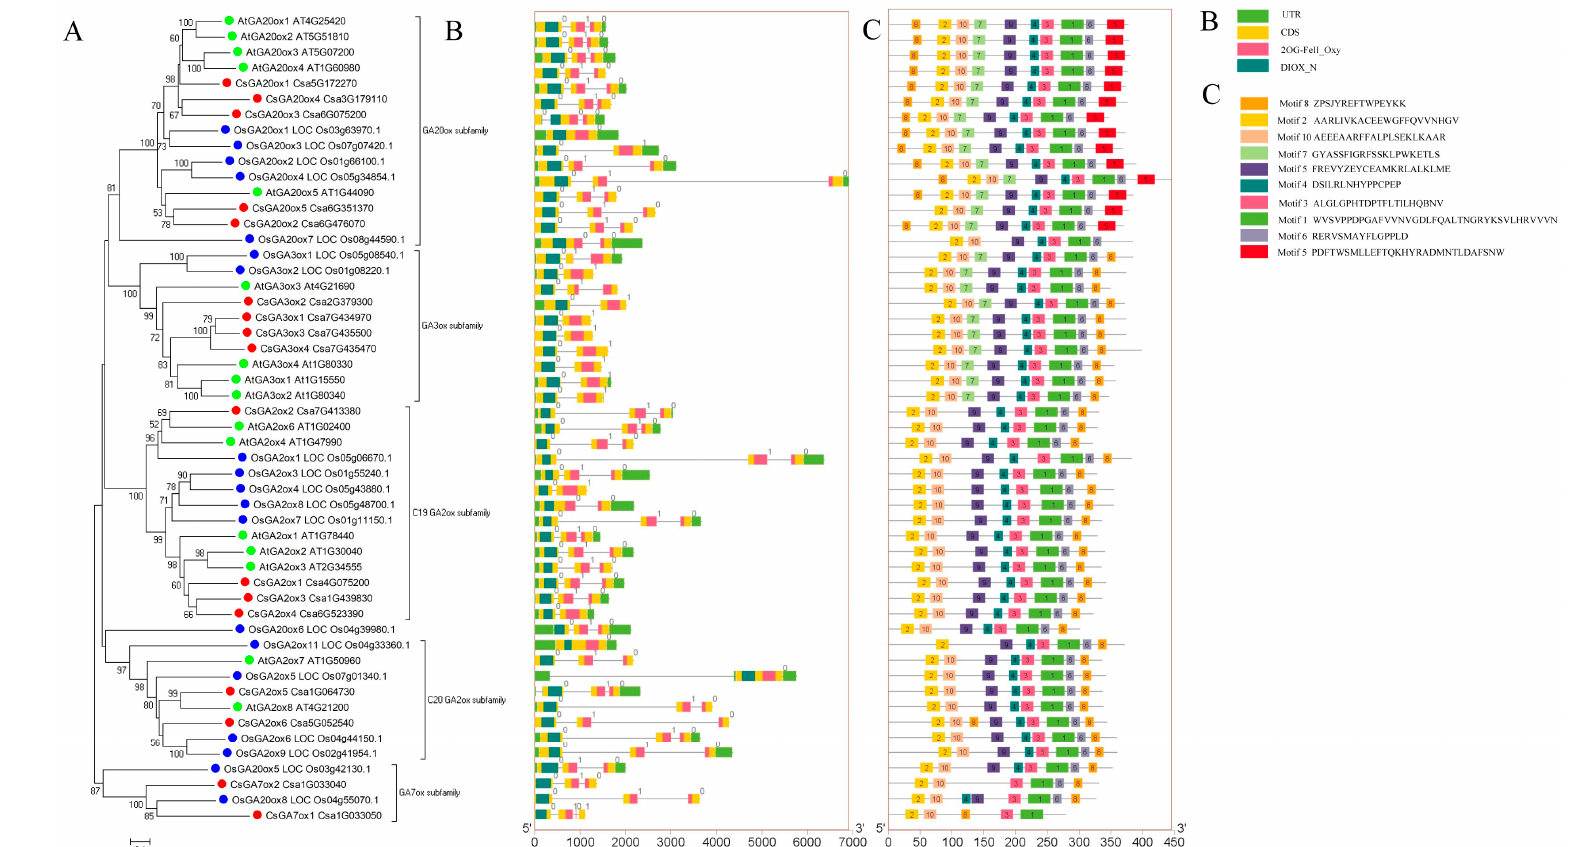
Figure 1. Phylogenetic relationships, gene structure and conserved protein motifs in GAox genes from cucumber. ( A ) The phylogenetic tree was constructed based on the full-length protein sequences of 17 CsGAox, 16 AtGAox and 19 OsGAox proteins using MEGA 7.0 software. Cucumber, Arabidopsis and rice GAoxs were labeled by red, green and blue dots; ( B ) Exon-intron structure of CsGAox genes. Black lines indicate introns. The 2OG-FeII_Oxy and DIOX_N domain is highlighted by red and dark green boxes, respectively. The number indicates the phases of corresponding introns; ( C ) The motif composition of CsGAox proteins. The motifs, numbers 1–10, are displayed in different colored boxes. The sequence logos and E values for each motif are given in Figure S3.